Question: Is the quantity shown trending increasing or decreasing?
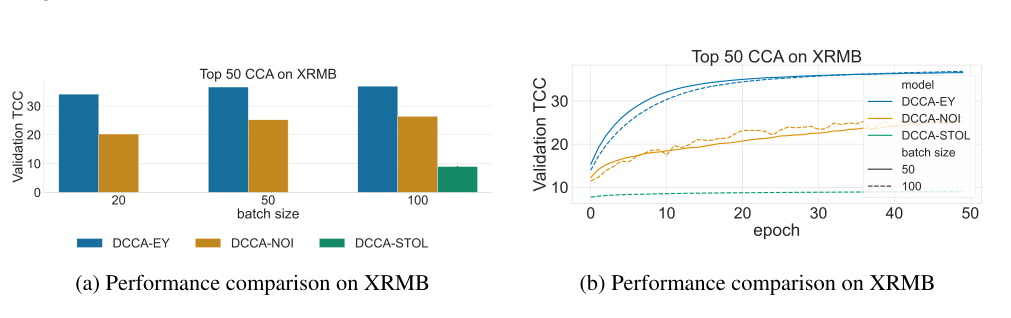
Answer: increasing